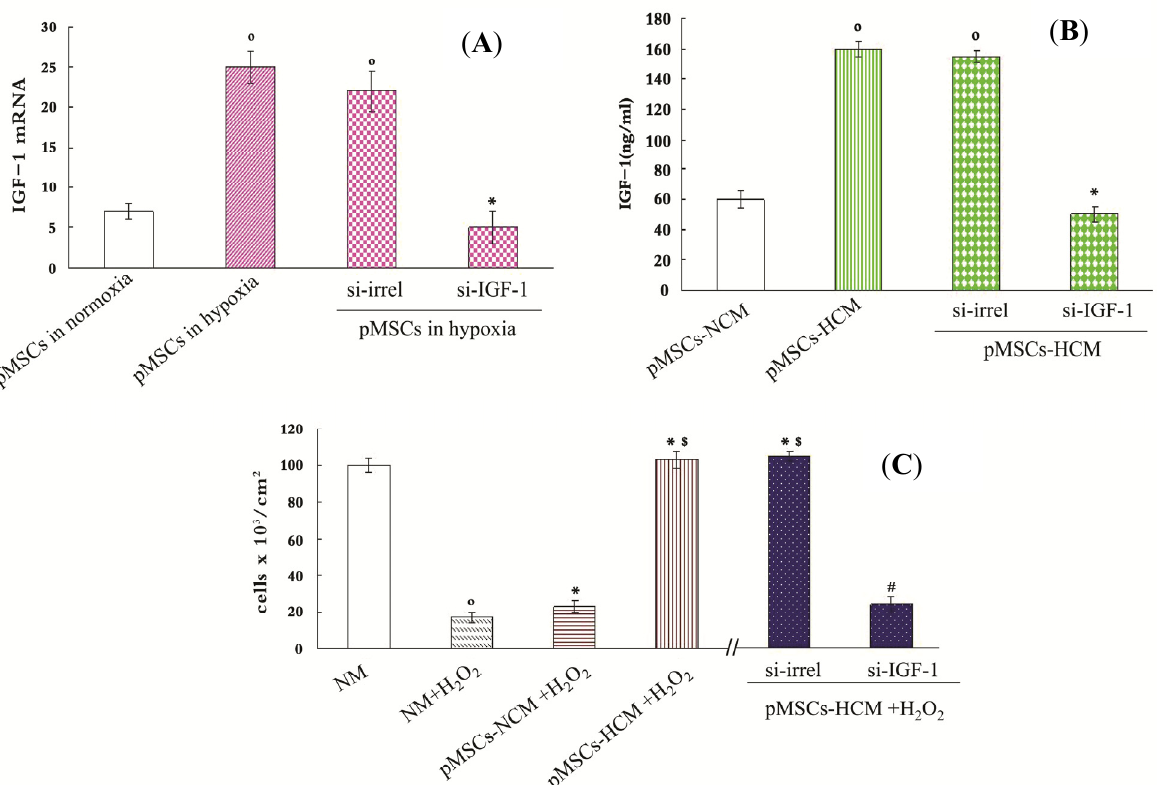
O ; $ p < 0.05 2 2 O ( n = 6); 2 2 O -treated caco2 2 2 O ; # p < 0.05 versus 2 2